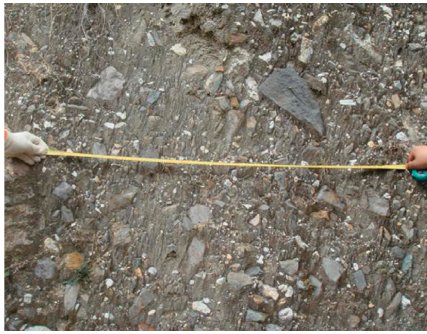
Figure 5: Samples being collected from Mahe talus slide.